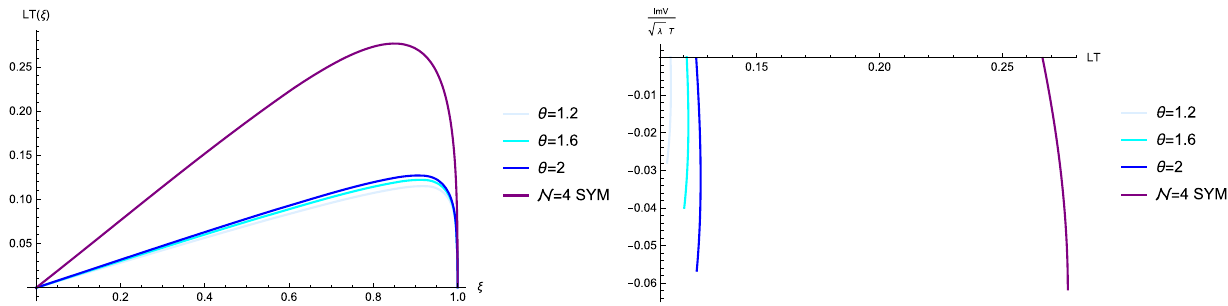
√ / λ T versus LT in the different θ at z = 2 . 6 and QQ